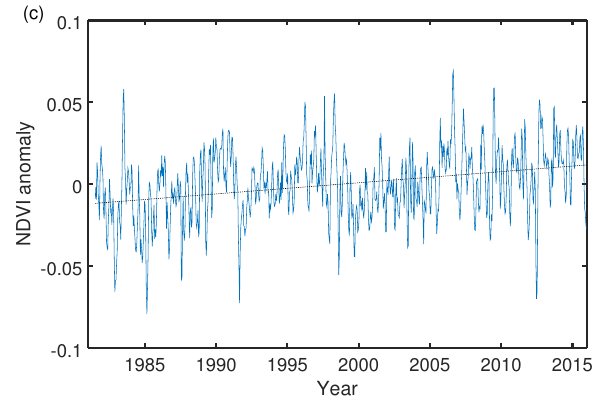
Figure 5. ( a ) Time series of mean Nepal normalized difference vegetation index (NDVI). ( b ) Mean seasonal cycle of NDVI. ( c ) NDVI anomaly (subtracting the mean seasonal cycle) and its least-squares linear fit.